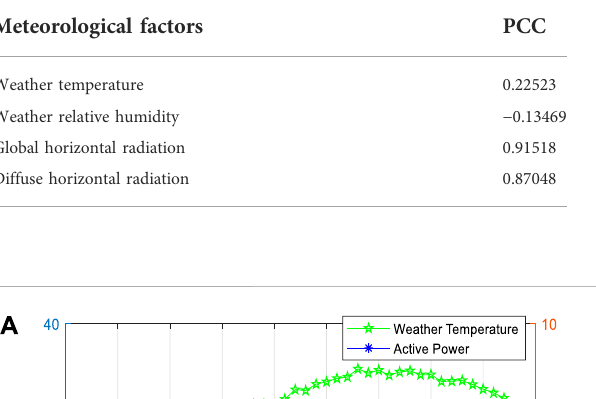
TABLE 1 PCC of meteorological factors and active power.